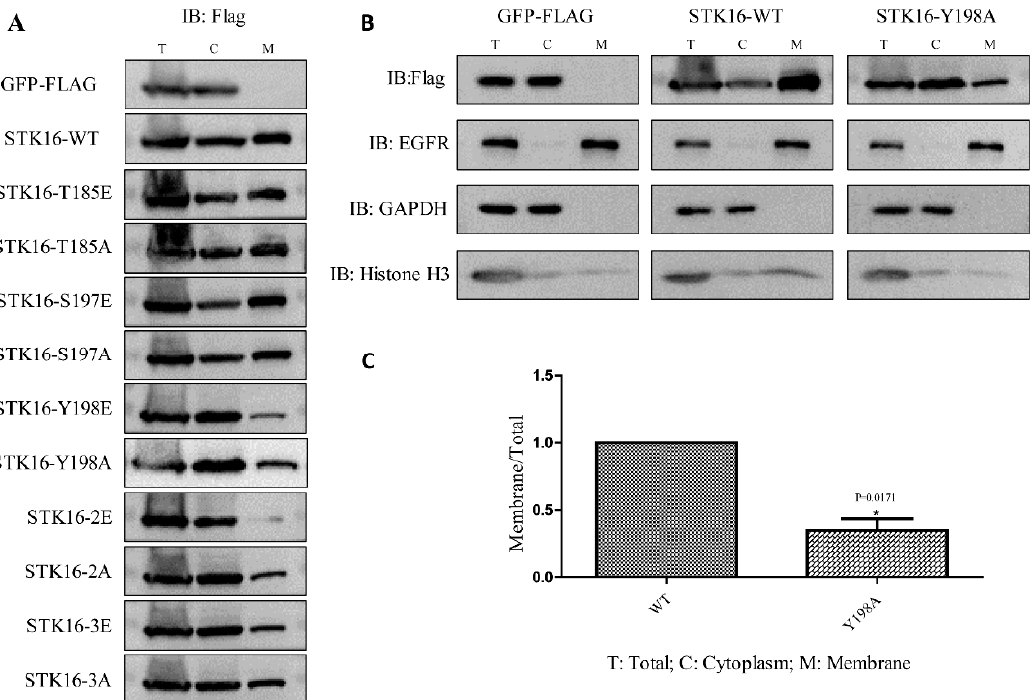
Figure 4. Phosphorylation at Tyr198 affects the localization of STK16 in the cell membrane. ( A , B ) HeLa cells stably expressing GFP-FLAG (vector control), STK16 WT-GFP-FLAG and STK16 mutants-GFP-FLAG were grown in 35 mm dishes with 90% confluence, and then fractionated into the cytoplasm (C) and cell membrane (M). ( A ) The amount of wild type and mutant STK16 in both components of each cell line were detected by Western blot. ( B ) Markers were used to verify fractionation e ffi ciency. ( C ) Quantification of STK16 concentrations on the cell membrane and cytoplasm in HeLa-STK16 WT-GFP-FLAG and HeLa-STK16 Y198A-GFP-FLAG cells were shown. The data were analyzed using Student’s t -test. Data show mean ± SEM, n =